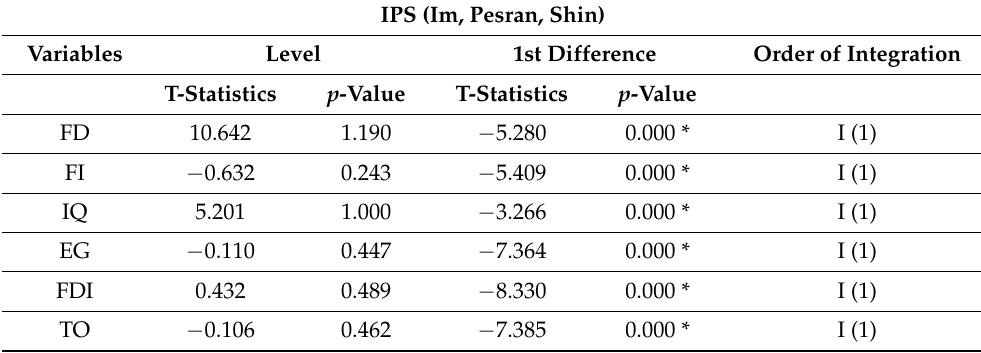
Table 2. Panel unit root results.